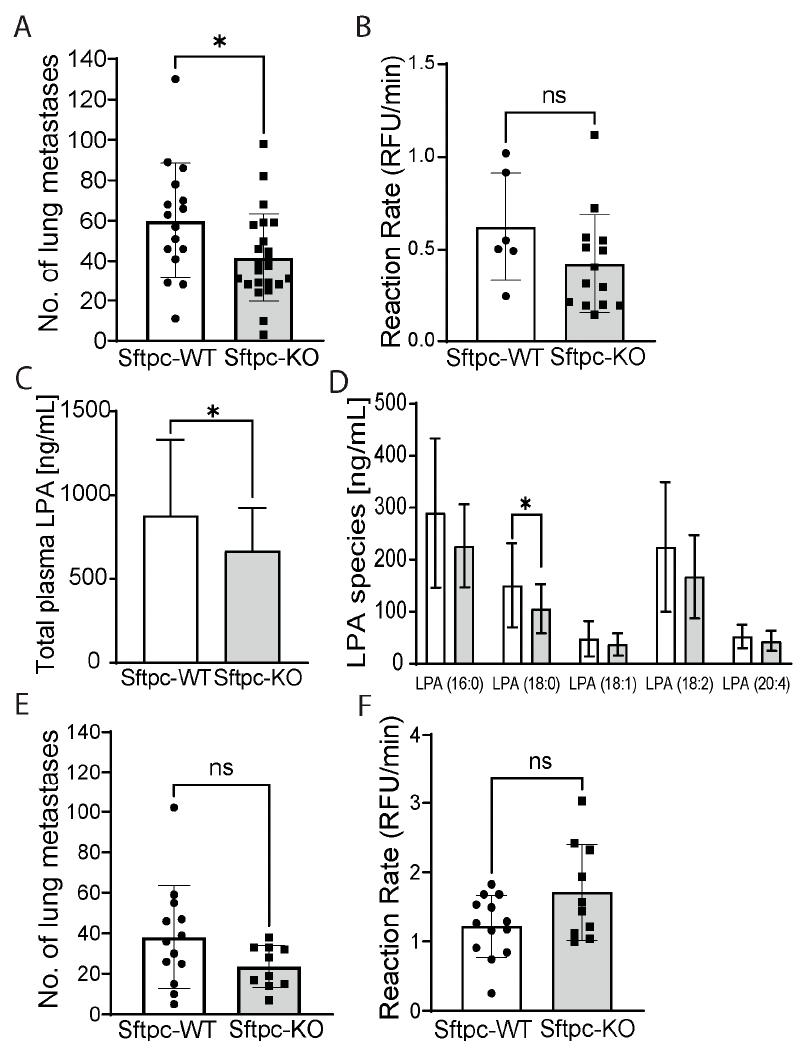
Figure 3. Only combined KO of ATX in B16-F10 cells and ATII cells decreases lung metastasis burden compared to KO in ATII cells alone. ( A ) Metastatic nodules in the lungs of Sftpc-WT (white bar, n = 16) and Sftpc-KO (gray bar, n = 23) mice inoculated with 1.5 × 10 5 ATX-KO B16-F10 cells. Sftpc-KO mice showed a 30% decrease in metastatic nodules (unpaired t -test, * p = 0.028 from 2 independent experiments). ( B ) ATX activity in the BALF from Sftpc-WT (white bar, n = 6) and Sftpc-KO (gray bar, n = 14) mice inoculated with 1.5 × 10 5 ATX-KO B16-F10 cells. There was no statistical difference between the two genotypes (unpaired t -test, p = 0.1551). ( C ) Total LPA species in the plasma of Sftpc-WT (white bar, n = 16) and Sftpc-KO (gray bar, n = 23) analyzed by mass spectrometry. Values are mean ± SD. Unpaired t -test, * p = 0.0426. ( D ) LPA species in the plasma of Sftpc-WT (white bar, n = 16) and Sftpc-KO (gray bar, n = 23) mice analyzed by mass spectrometry. Values are mean ± SD. * p = 0.0305, unpaired t -test. ( E ) Metastatic nodules in the lungs of Sftpc-WT (white bar, n = 13) and Sftpc-KO (gray bar, n = 10) mice inoculated with 1.5 × 10 5 WT B16-F10 cells. There was no statistical difference between the two genotypes (unpaired t -test, p = 0.1063). ( F ) ATX activity in the BALF